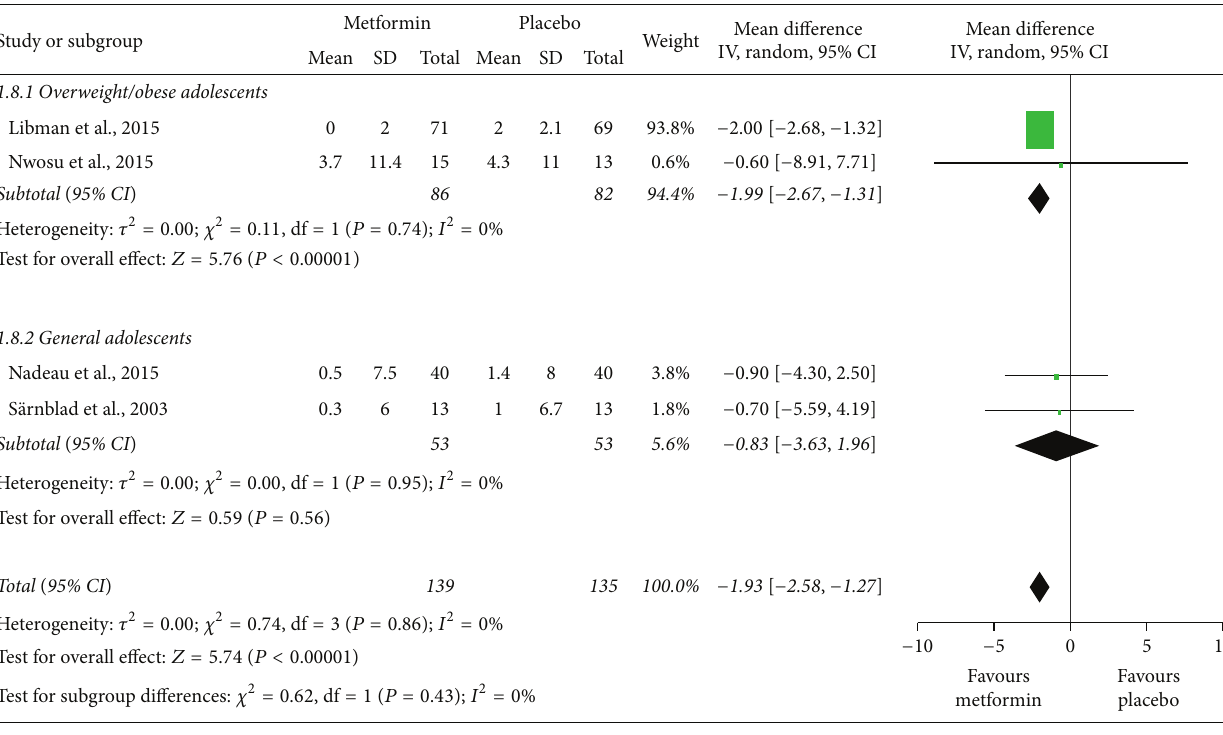
Figure 5: Mean differences in changes in body weight from baseline to study termination between patients who received adjunctive metformin therapy or placebo in adolescents with type 1 diabetes mellitus. CI: confidence interval; IV: inverse